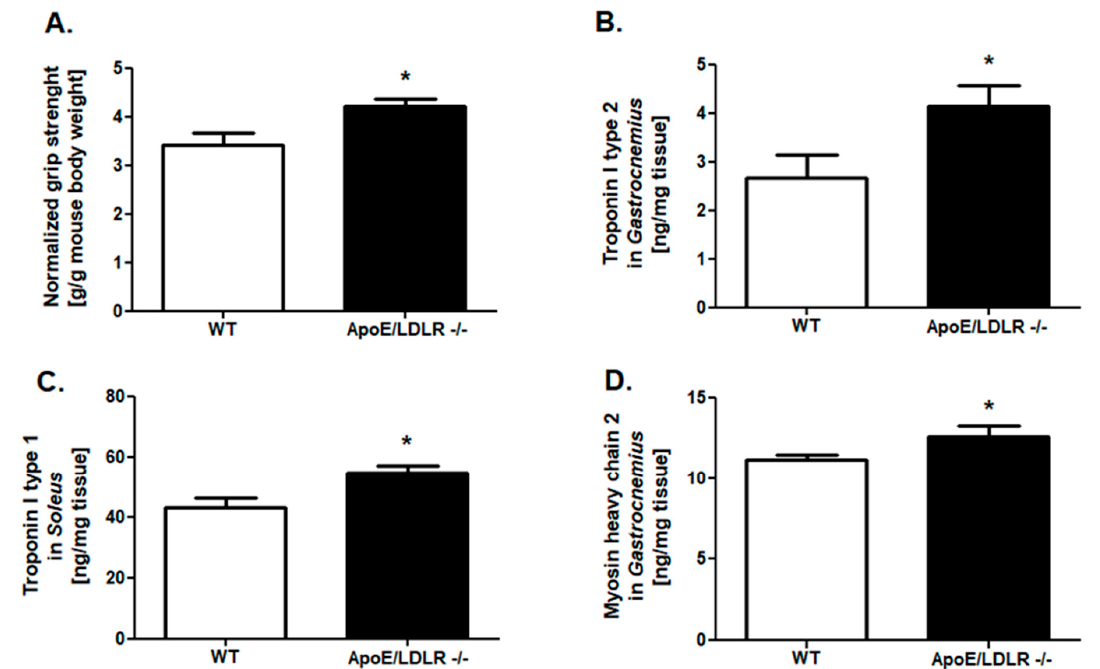
Figure 1. Improved forelimb grip strength, increased skeletal muscle troponins, and skeletal muscle myosin heavy chain 2 levels in ApoE/LDLR -/- mice. Normalized forelimb grip strength (maximum forelimb grip strength/g of body weight) ( A ), troponin I type 2 levels in gastrocnemius (fast skeletal muscle) ( B ), troponin I type 1 level in soleus (slow skeletal muscle) ( C ) and ( D ) myosin heavy chain 2 levels in gastrocnemius of control (WT), and ApoE/LDLR -/- mice. Results presented as mean ± SEM, n = 6–8, * p < 0.05.